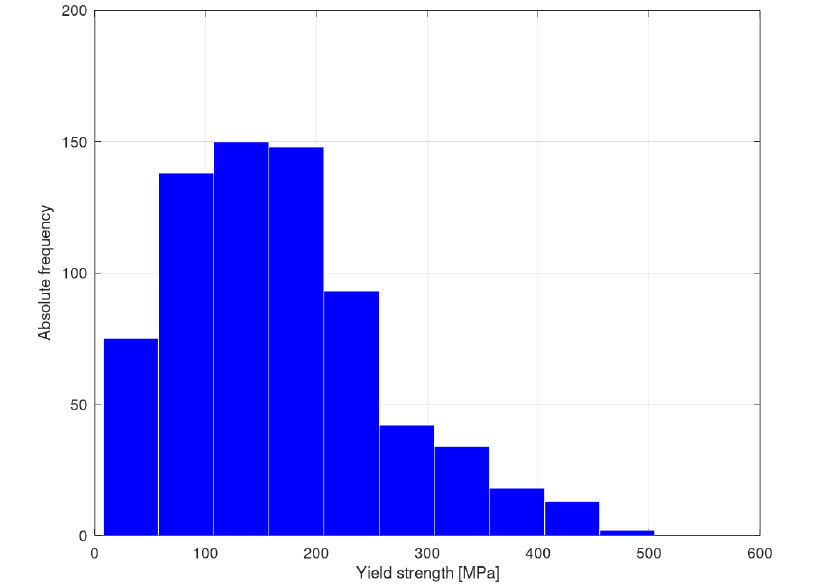
Figure A1. Yield strength histogram of the input